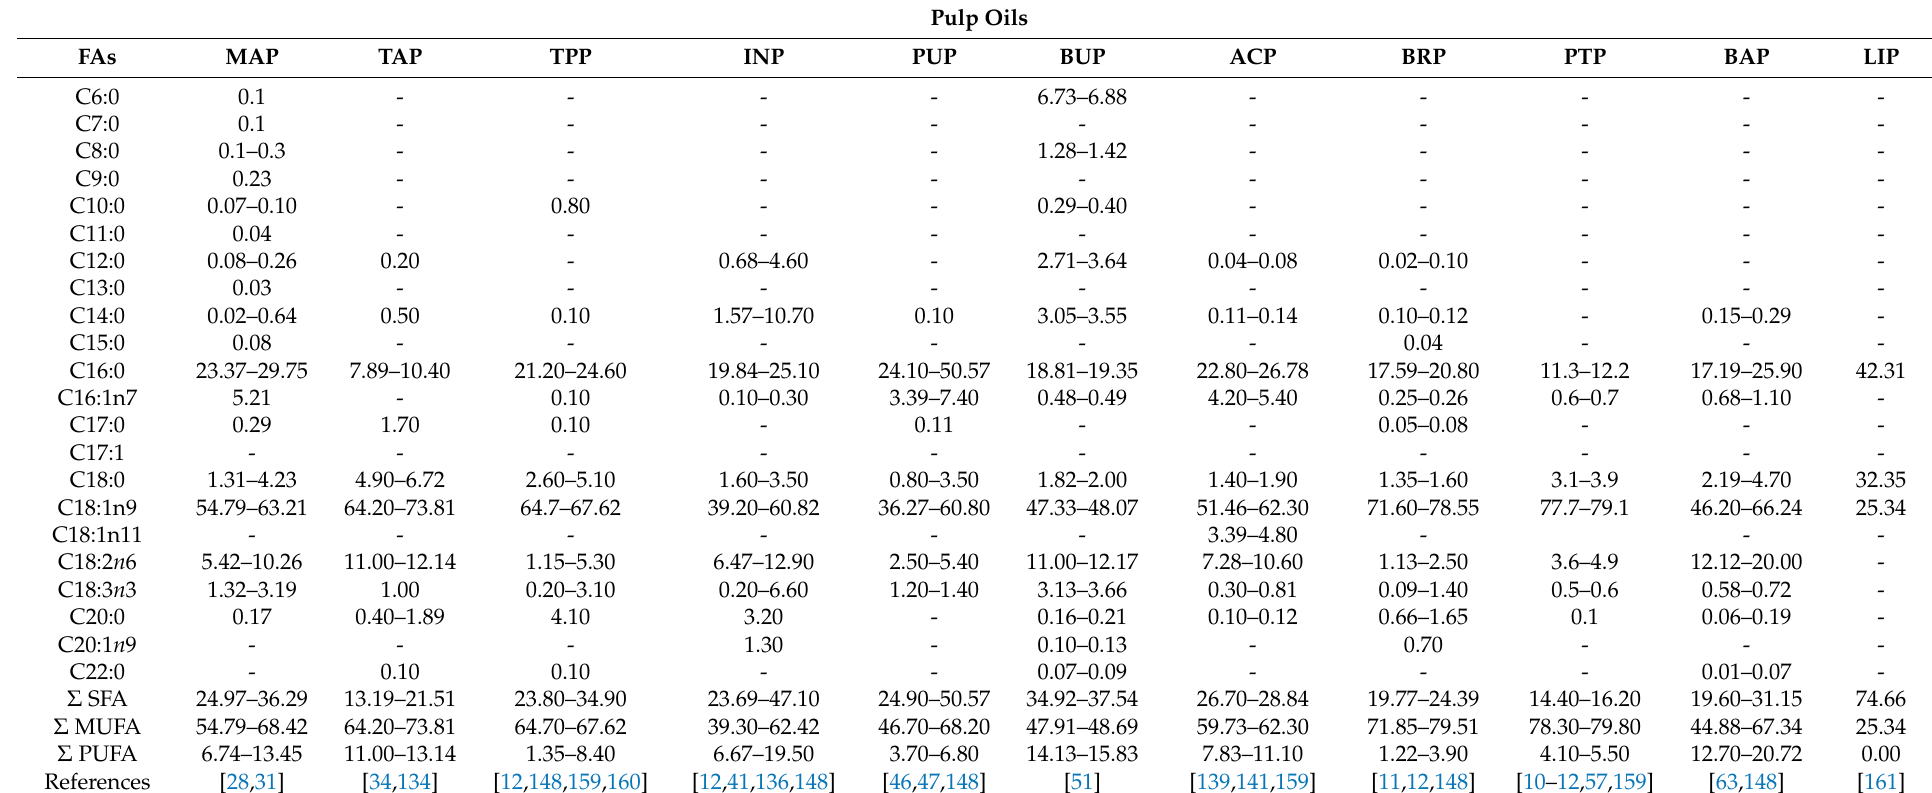
Table 3. Fatty acid (FA) composition (%) of different oils from pulp and kernels of Arecaceae palm